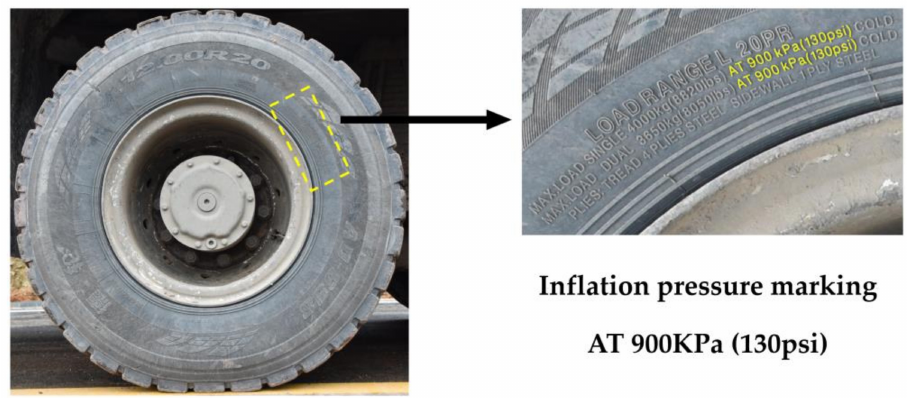
Figure 16. Inflation pressure